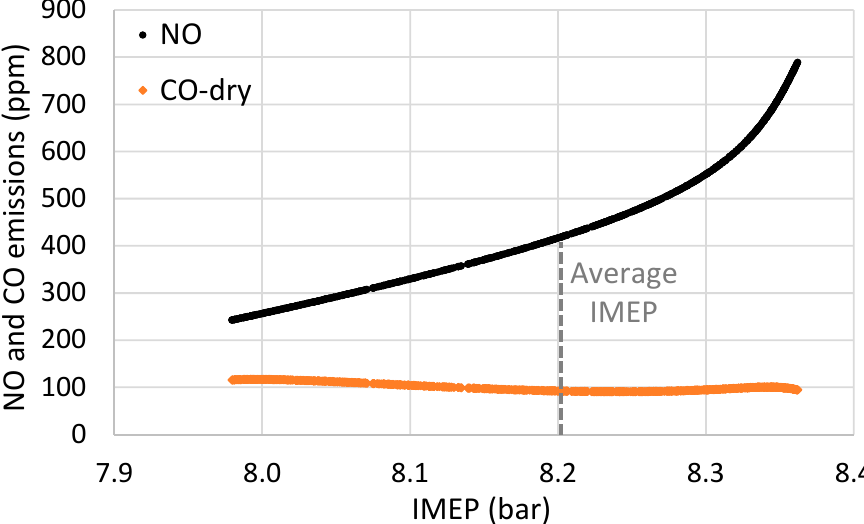
Figure 9. NO and CO-dry emissions as a function of the IMEP for the case of 1000 cycles.